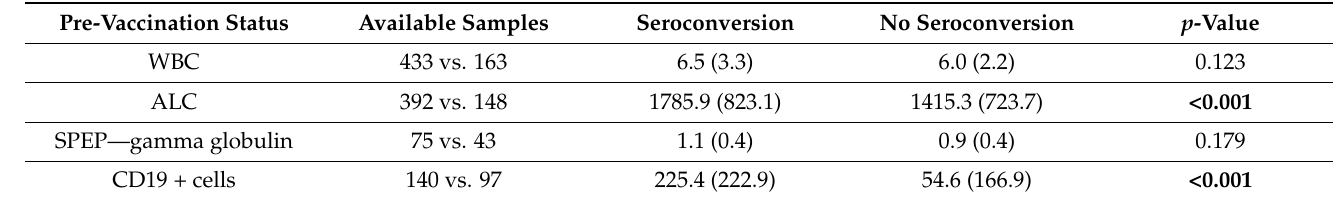
Table 4. Effects of white blood cell count and absolute lymphocyte count on seroconversion to COVID-19